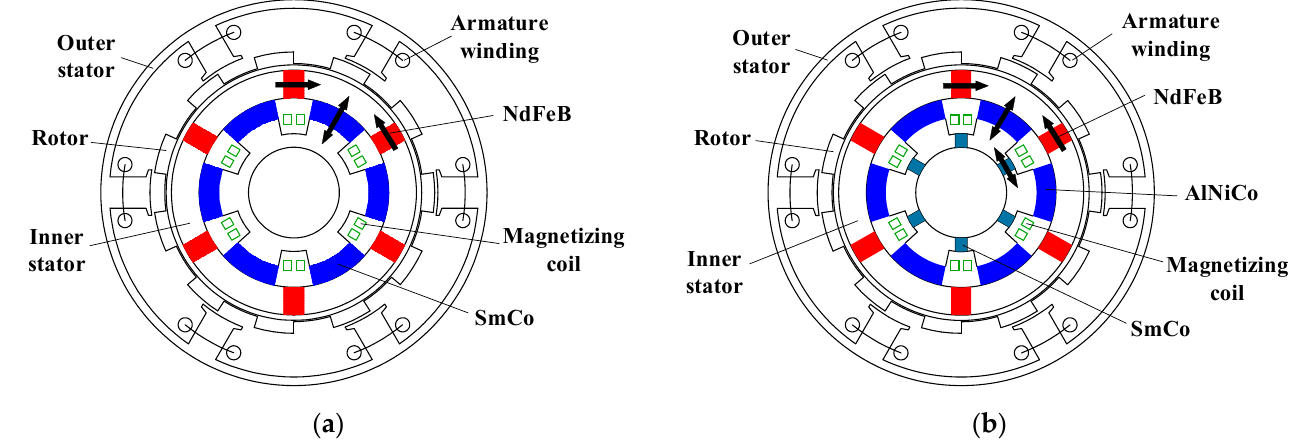
Figure 41. Dual ‐ stator VF ‐ SFPM machines with different PM arrangements [107]. ( a ) Dual ‐ PM. ( b ) Figure 41. Dual-stator VF-SFPM machines with different PM arrangements [107]. ( a ) Triple ‐ PM.